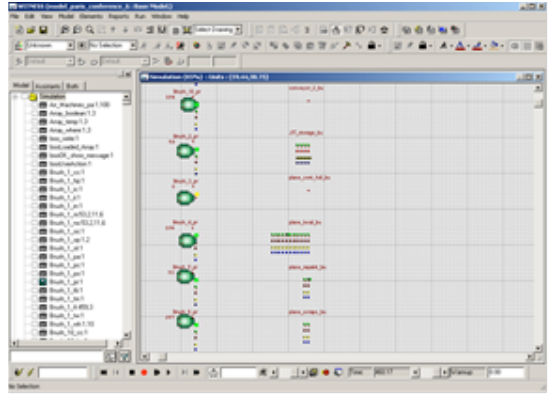
Fig. 6. Illustration of Witness simulation